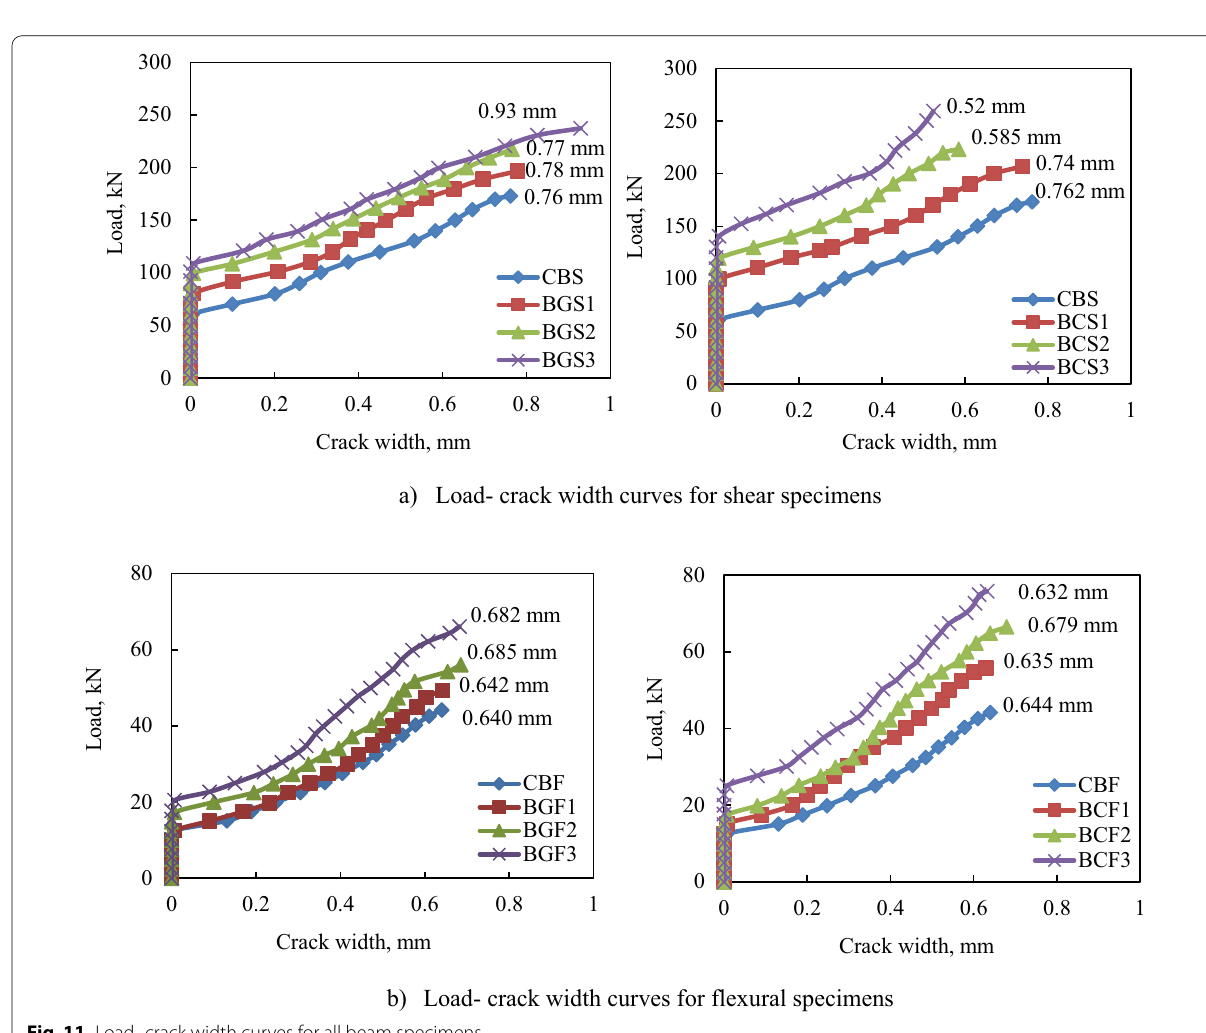
Fig. 11 Load–crack width curves for all beam